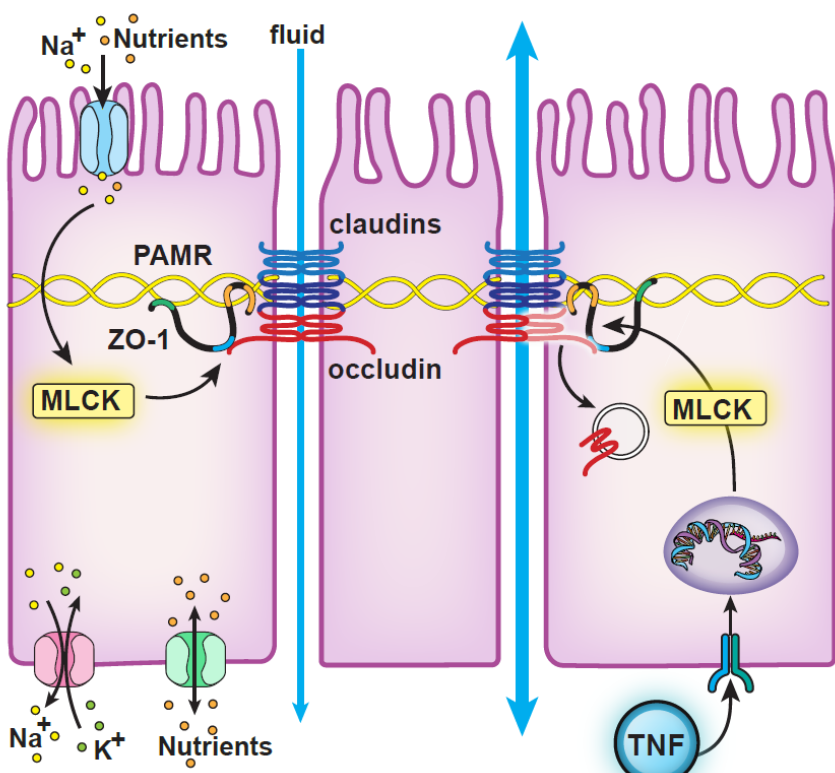
Figure 2. Roles of myosin light chain kinase (MLCK) in physiological and pathophysiological tight junction regulation. PAMR: perijunctional actomyosin ring; TNF: tumor necrosis factor. junction regulation. PAMR: perijunctional actomyosin ring; TNF: tumor necrosis